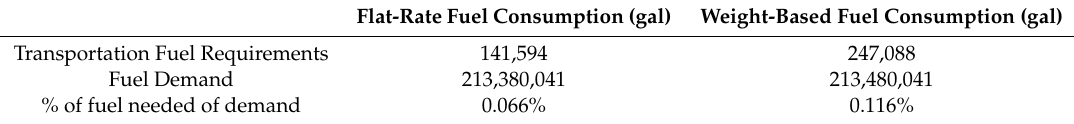
Figure 13. Change in biomass concentration with time inside the Raceway Pond for Kay County.